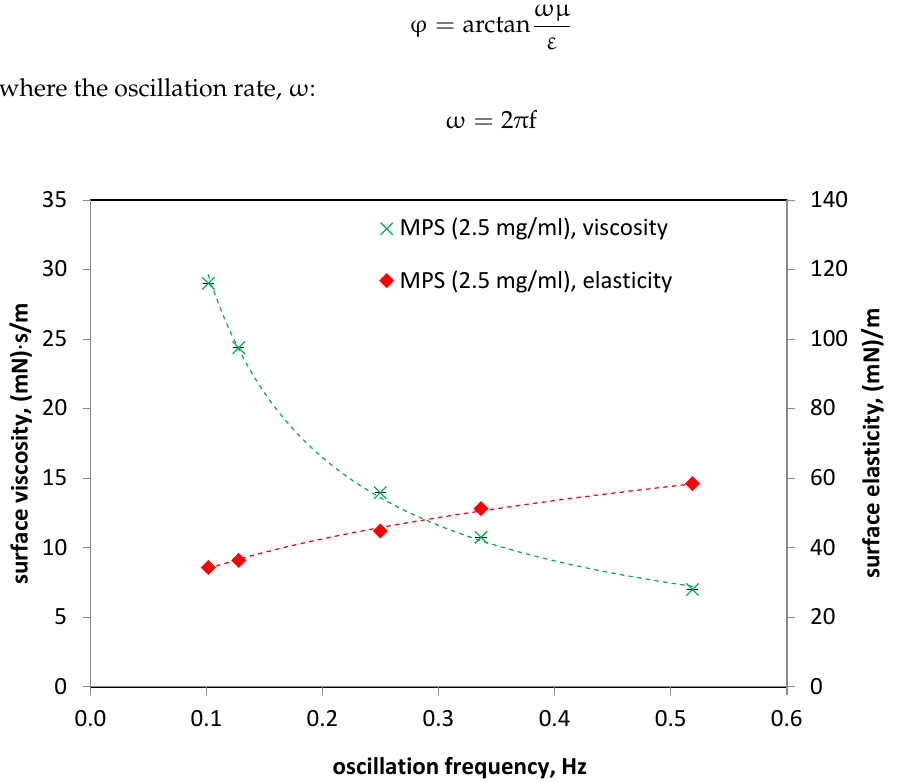
Figure 5. The effective dilatational rheological parameters of air–liquid interface with the lipid–protein model of the pulmonary surfactant, MPS (concentration 2.5 mg/mL).